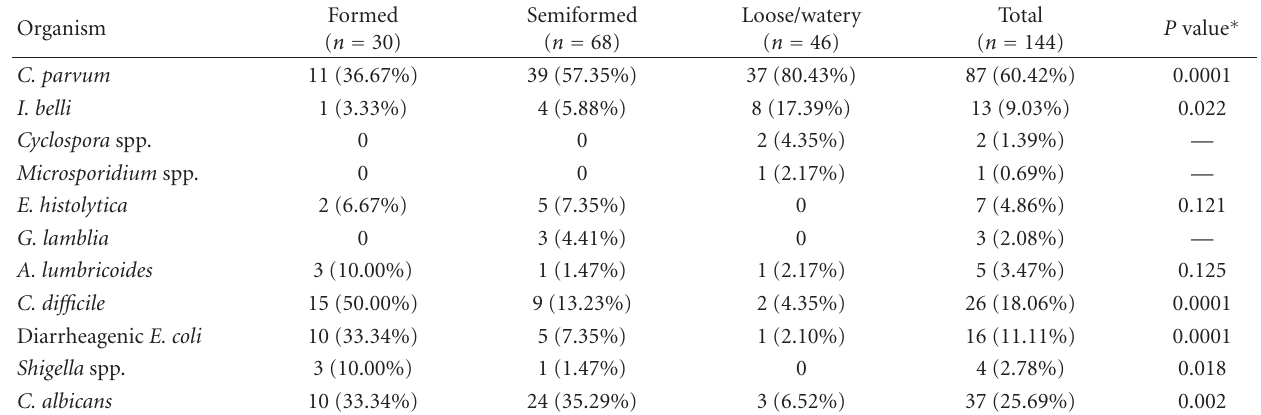
Table 3: Frequency of enteric pathogens isolated in relation to stool consistency ( n = 144).